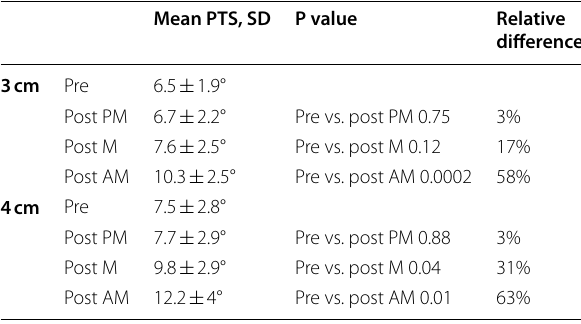
Table 3 Independent comparisons of preoperative and postoperative PTS in the 3 and 4 cm